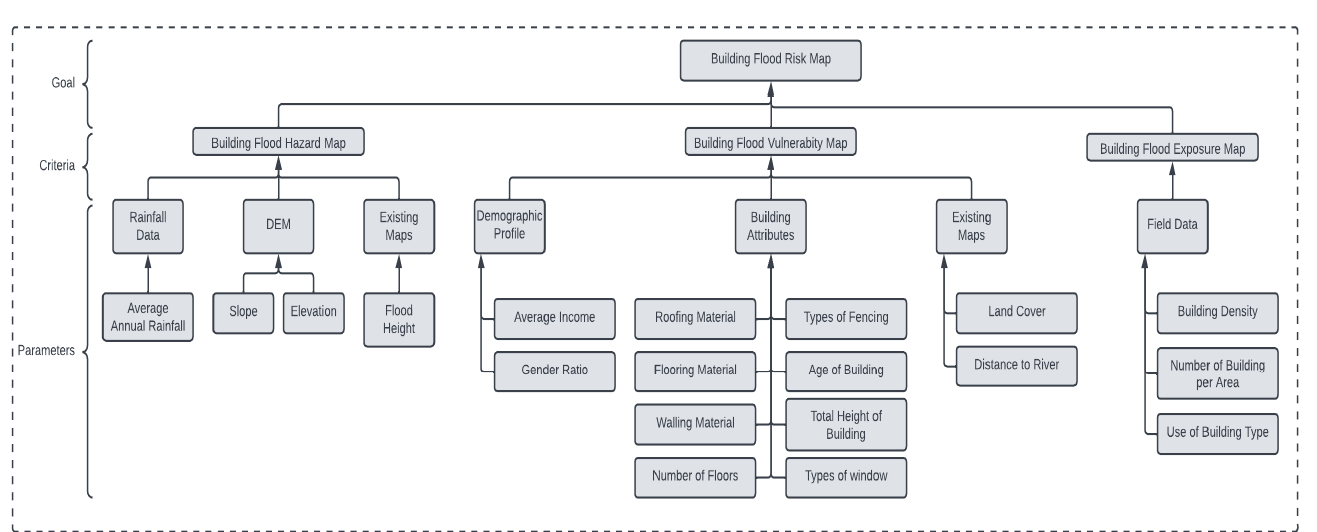
Figure 5. Result maps for building flood exposure parameters using ArcMap: ( a ) building density,